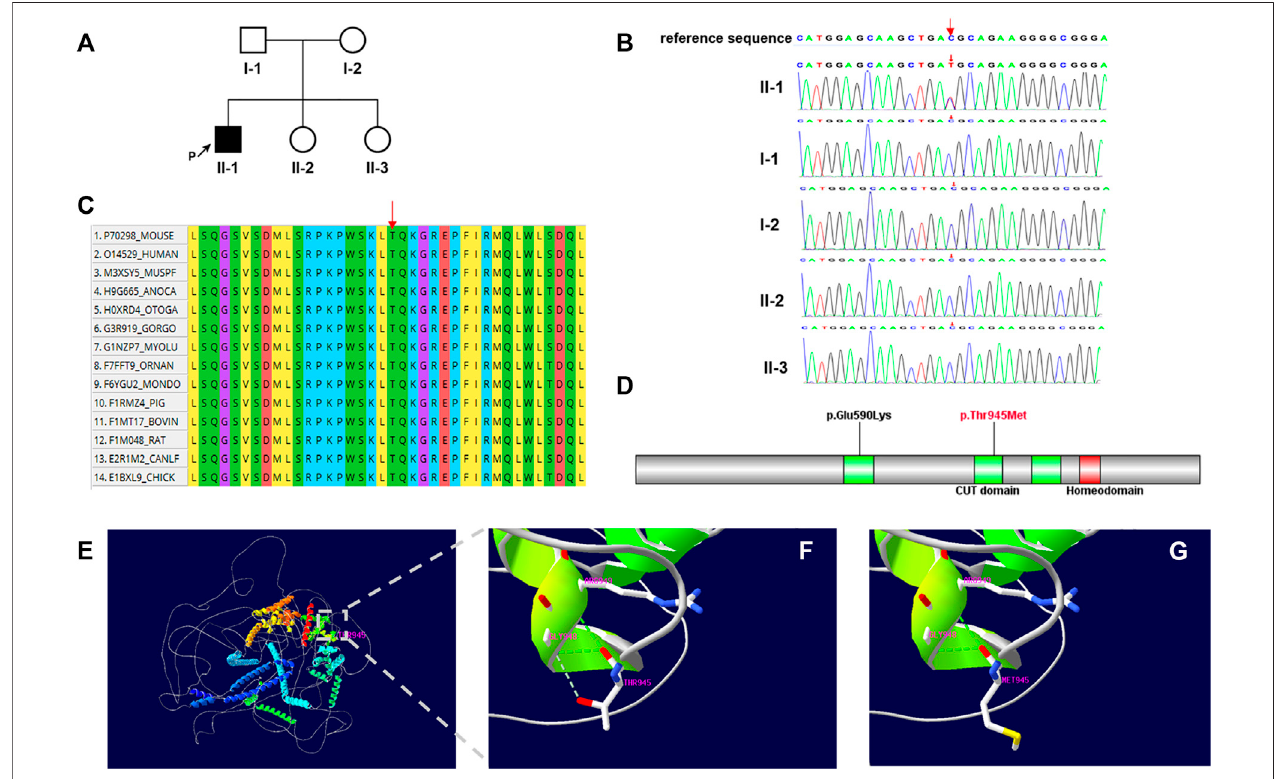
FIGURE 1 | (A) Family pedigree. The black arrow indicates the proband. (B) Sanger sequencing of the patient and family members con fi rmed the de novo variant c.2834C > T. (C) Multiple-sequence alignment of CUX2 protein among species. Red arrow shows the Thr945 site. (D) Domain structure of CUX2 protein (CUT domain, green; Homeodomain, red). Localization of amino acid changes p.Glu590Lys and p.Thr945Met is indicated. (E – G) Structural model of the CUX2 protein. Ribbon representations show details of the second CUT domain for wild-type (p.Thr945) (F) and mutated (p.Thr945Met) (G) CUX2. Noted loss of the weaker hydrogen bond between Thr945 and Gly948. Green dashed lines: hydrogen bonds; grey dashed lines: weaker hydrogen